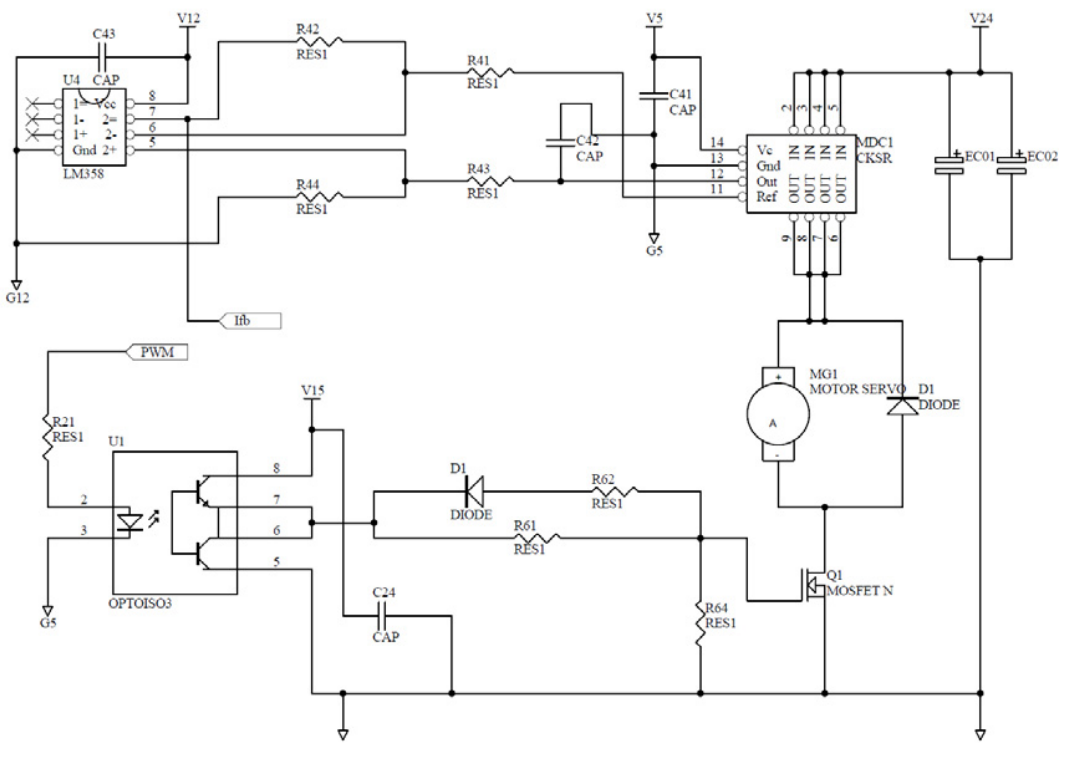
Figure 9. Sensor and driver circuits in the controller.